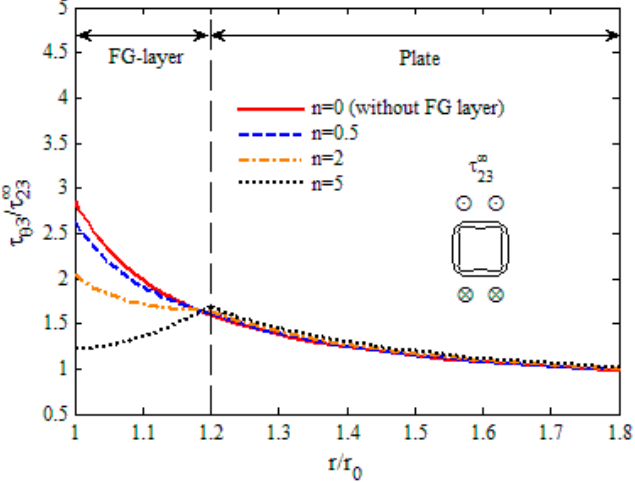
Appl. Sci. 2018 , 8 , x Figure 10. The variation in shear stress